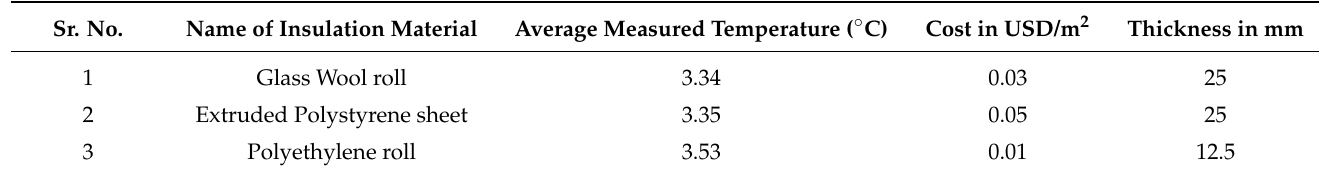
Table 4. Comparative analysis of average measured temperature, cost and thickness of experimented insulation materials.